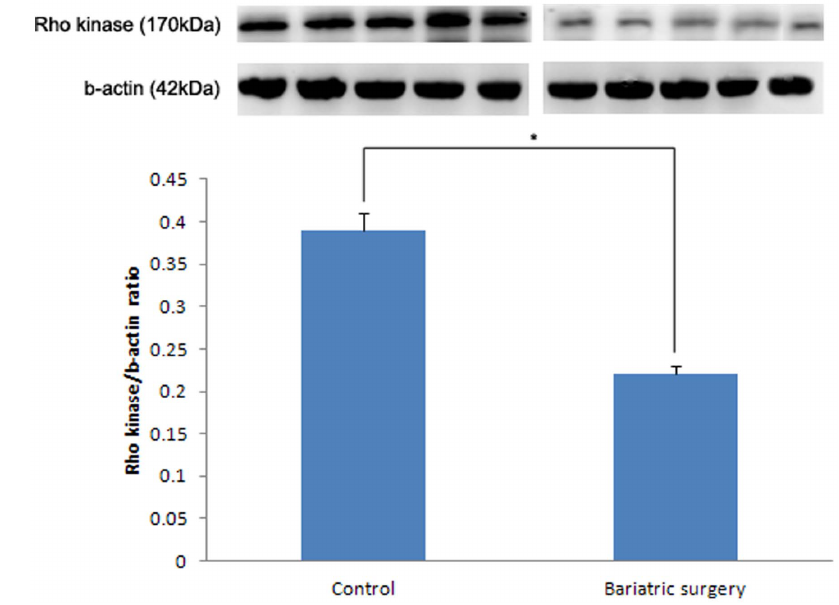
Figure 7. Rho kinase expression in the control and bariatric surgery groups (*: p=0.032).